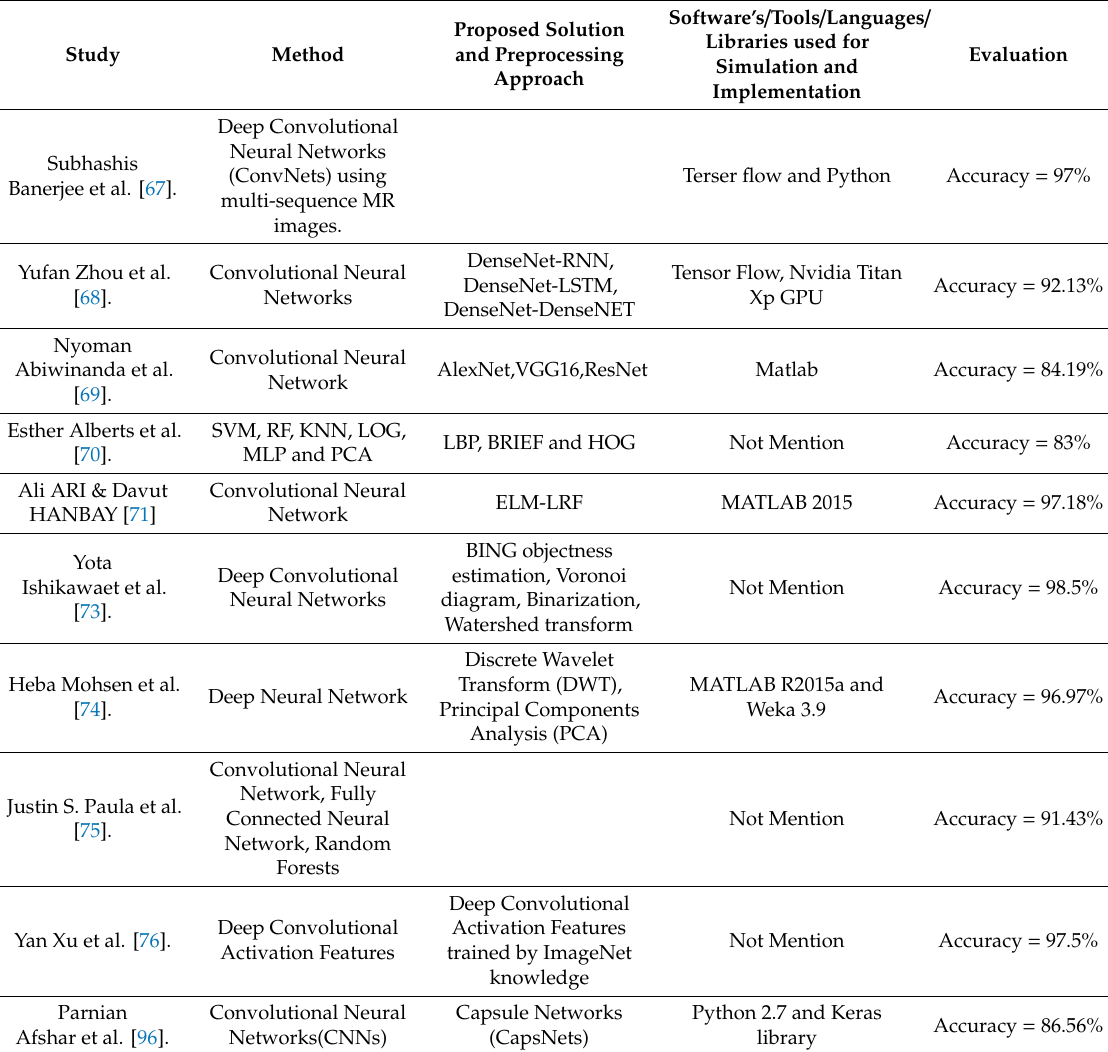
Table 2. Overview of papers using deep learning for brain tumor